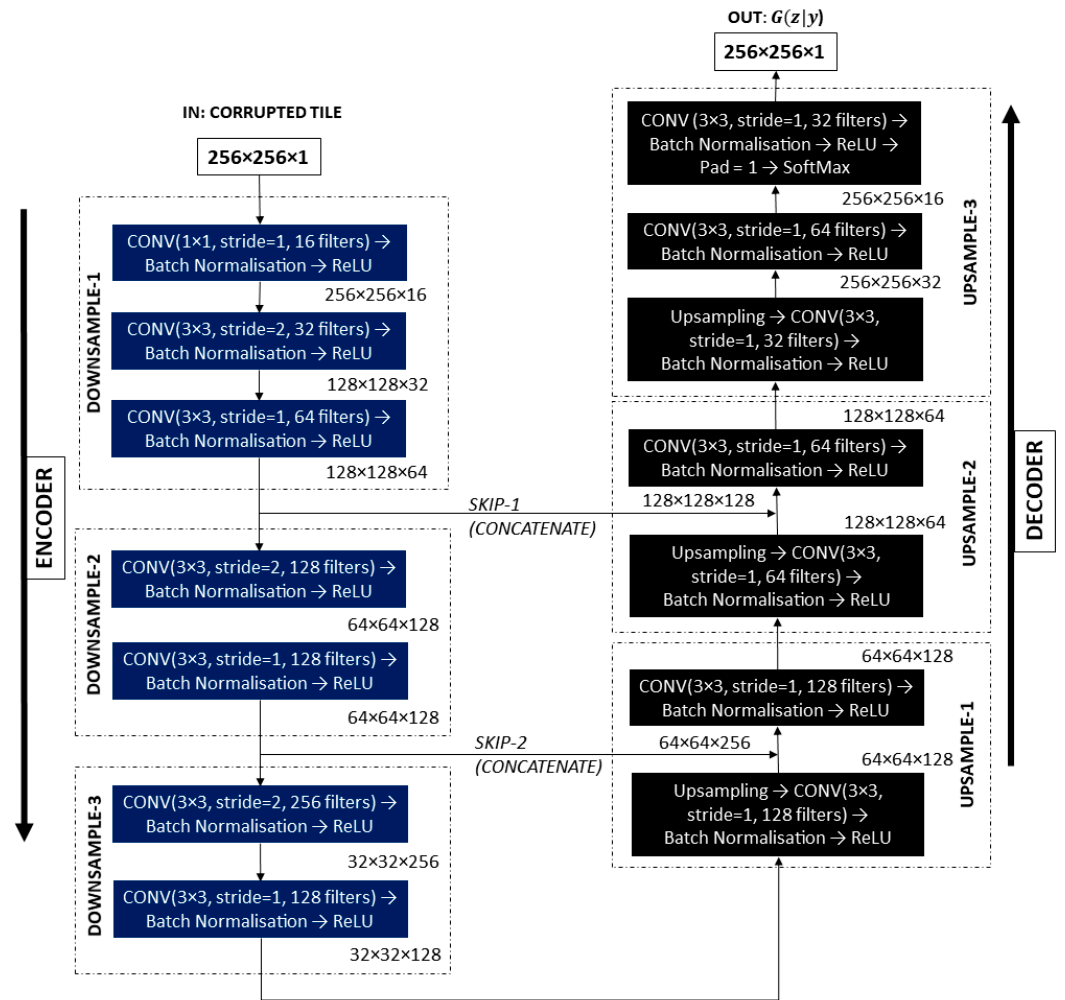
Figure 3. The generator architecture proposed for the deep inpainting operation.